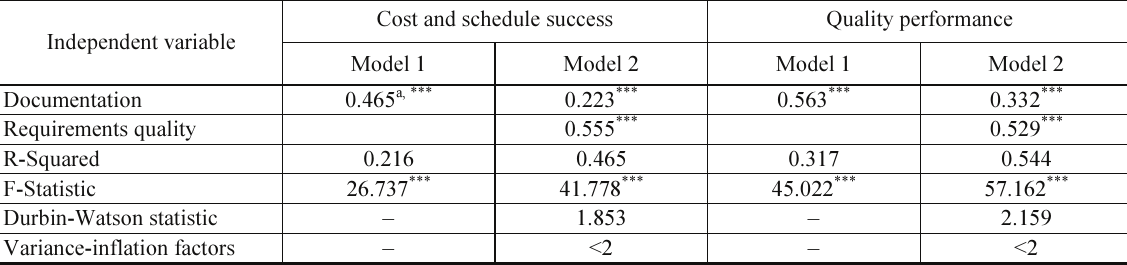
Table 3. Mediator between requirements documentation and project